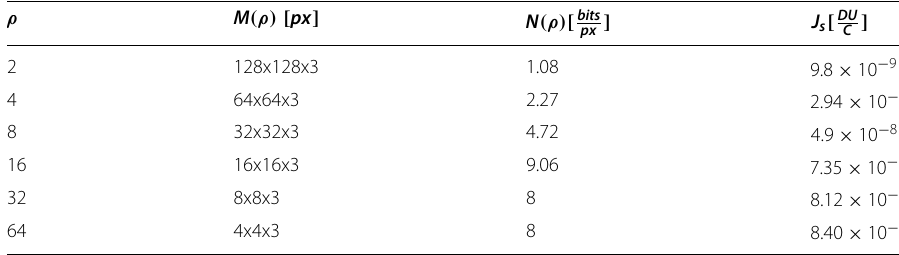
Table 4 Common parameters